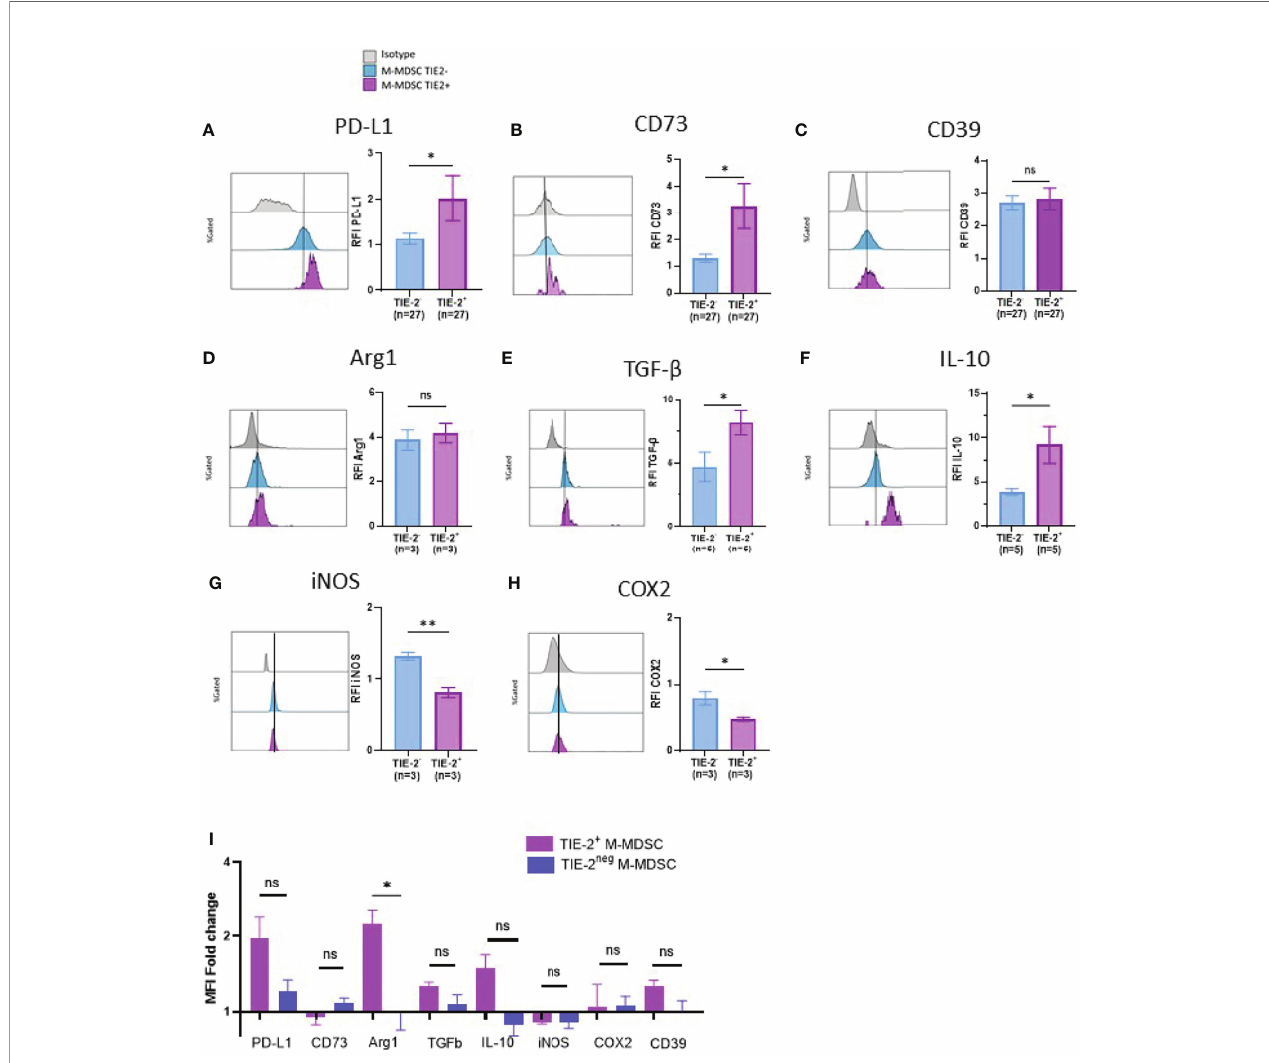
FIGURE 3 | Immune suppressive factors of TIE-2 + M-MDSC. (A – H) Expression of different proteins (PD-L1, CD39, CD73, Arg1, TGF- b , IL-10, iNOS, and COX2) was studied in TIE-2 + M-MDSC (TIE-2 + ) and TIE-2 − M-MDSC (TIE-2 − ). Left, histogram overlay from one representative patient of the mean fl uorescence intensity (MFI) of different proteins; right, relative fl uorescence intensity (RFI) of these proteins (Mann – Whitney test, *p < 0.1). (I) TIE-2 + M-MDSC enriched melanoma patients ’ peripheral blood mononuclear cells (PBMCs) were stimulated or not with 300 ng/ml of ANGPT2 overnight, and the expression of the different immunosuppressive proteins was analyzed by fl ow cytometry. Histograms of the MFI fold change. ns, no